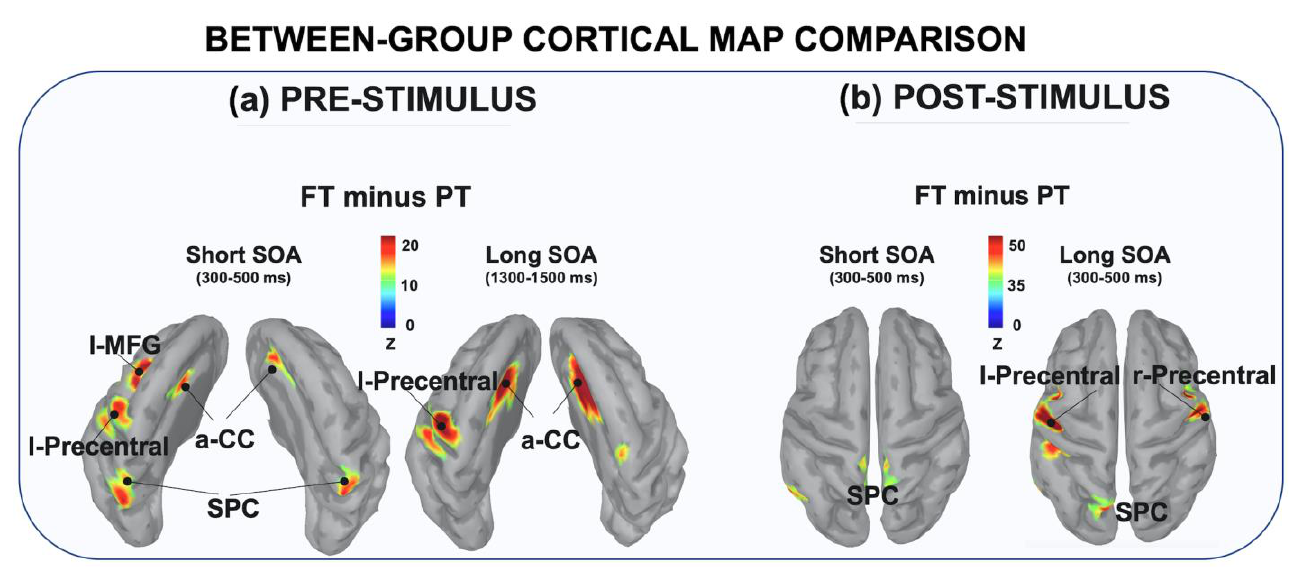
Figure 5. Between-group differential cortical map reconstruction. The pictures display the differen- tial (FT minus PT) cortical map reconstruction relative to each significant ERP effect for pre-stimulus ( a ) and post-stimulus ( b ) temporal windows. Data were adjusted using a threshold of 50% of the maximum amplitude and a size of at least 10 vertices and they were reported on a template cortex smoothed at 40%.